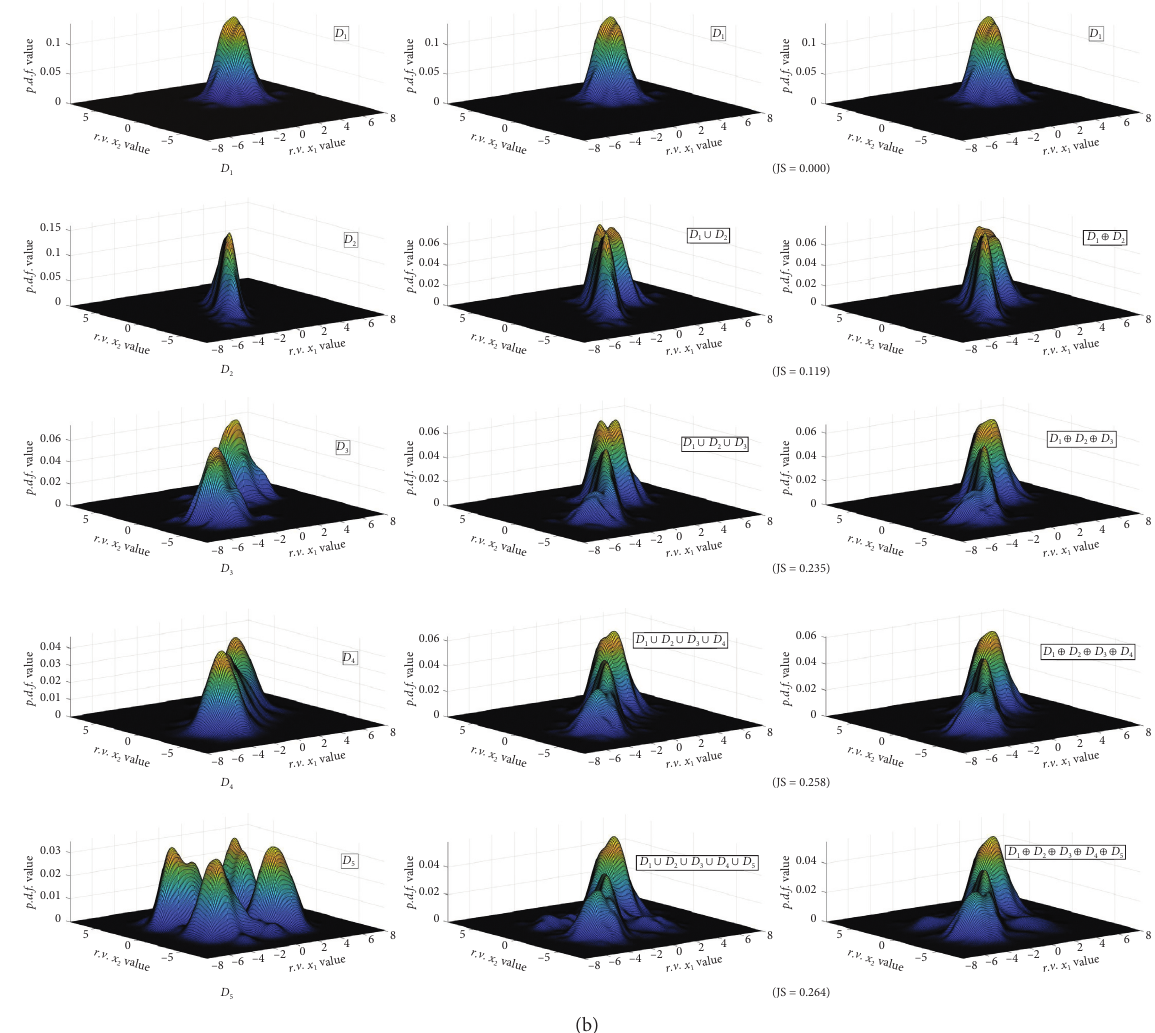
Figure 4: The convergence of the I-KDE on univariate and multivariate distributions. (a) Univariate case (the black curve represents the p.d.f . of newly coming data; the green curve represents the p.d.f . estimated with the KDE based on the combination of current data and newly coming data; and the red curve represents the p.d.f . estimated with the I-KDE in the way of data stream computation). (b) Multivariate case (the symbol ∪ represents the p.d.f . estimated with the KDE based on the combination of current data and newly coming data and the symbol ⊕ represents the p.d.f . estimated with the I-KDE in the way of data stream